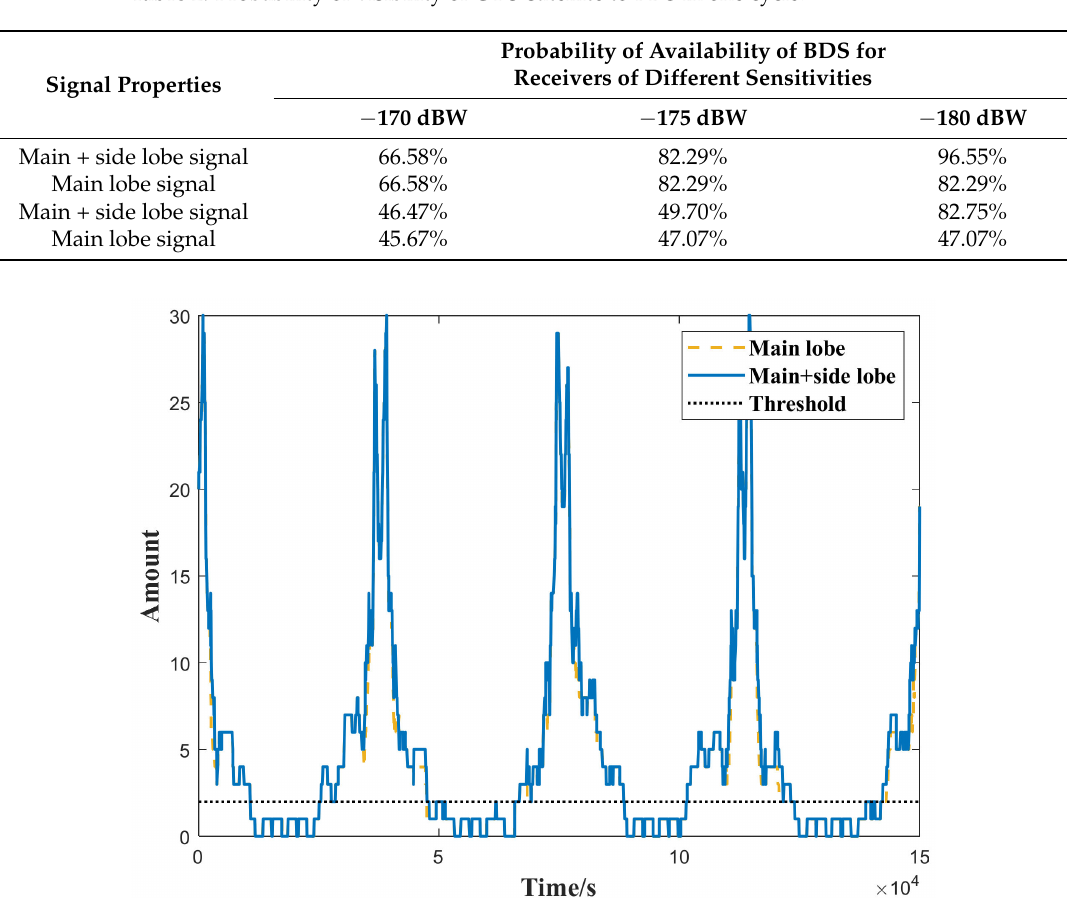
Table 2. Probability of visibility of GTO satellite to BDS in one cycle.